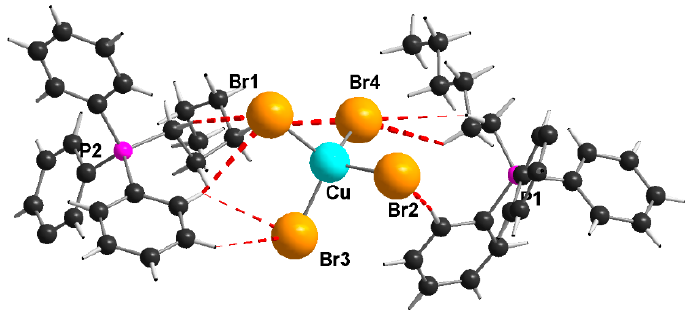
Table 4. Selected bond lengths and bond angles for (HexPh 3 P) 2 [CuBr 4 ] ( 8 ).